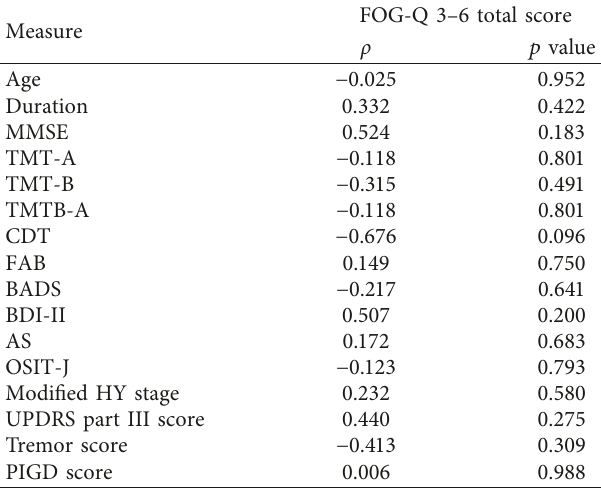
Table 2: Association of the FOG-Q 3–6 total scores with neuro- psychological test performance, olfactory function, and severity of motor